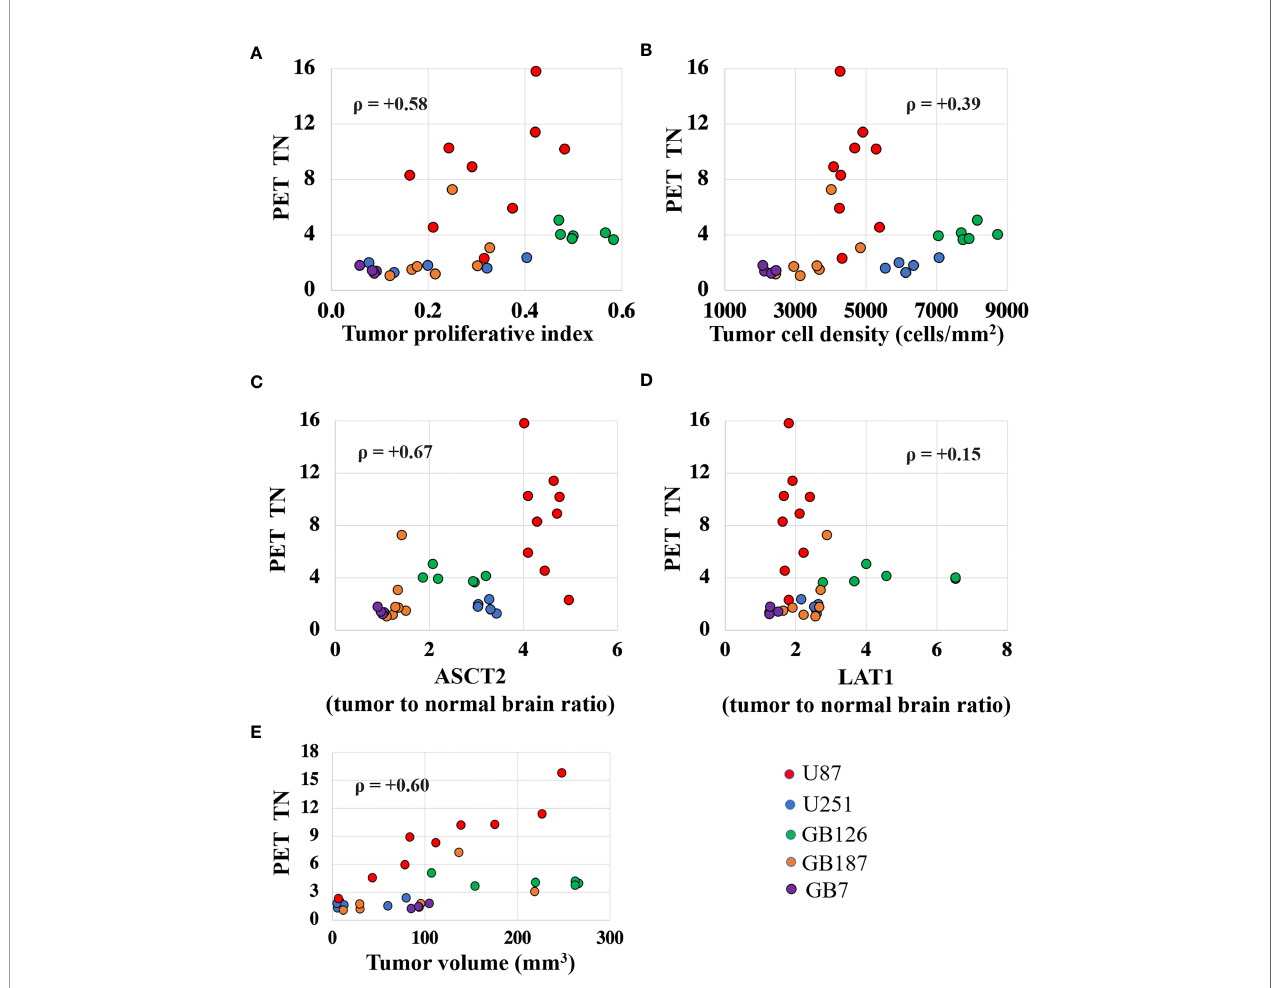
FIGURE 4 | Scatter plots showing the univariate relationship between the PET tumor-to-normal brain uptake ratio (TN 15-35 ) and the proliferative index (A) , cell density (B) , ASCT2 level (C) , LAT1 level (D) , and tumor volume (E) . Each data point represents measurements summarized for a single tumor and the color indicates the tumor line. The r value is the Spearman correlation coef fi